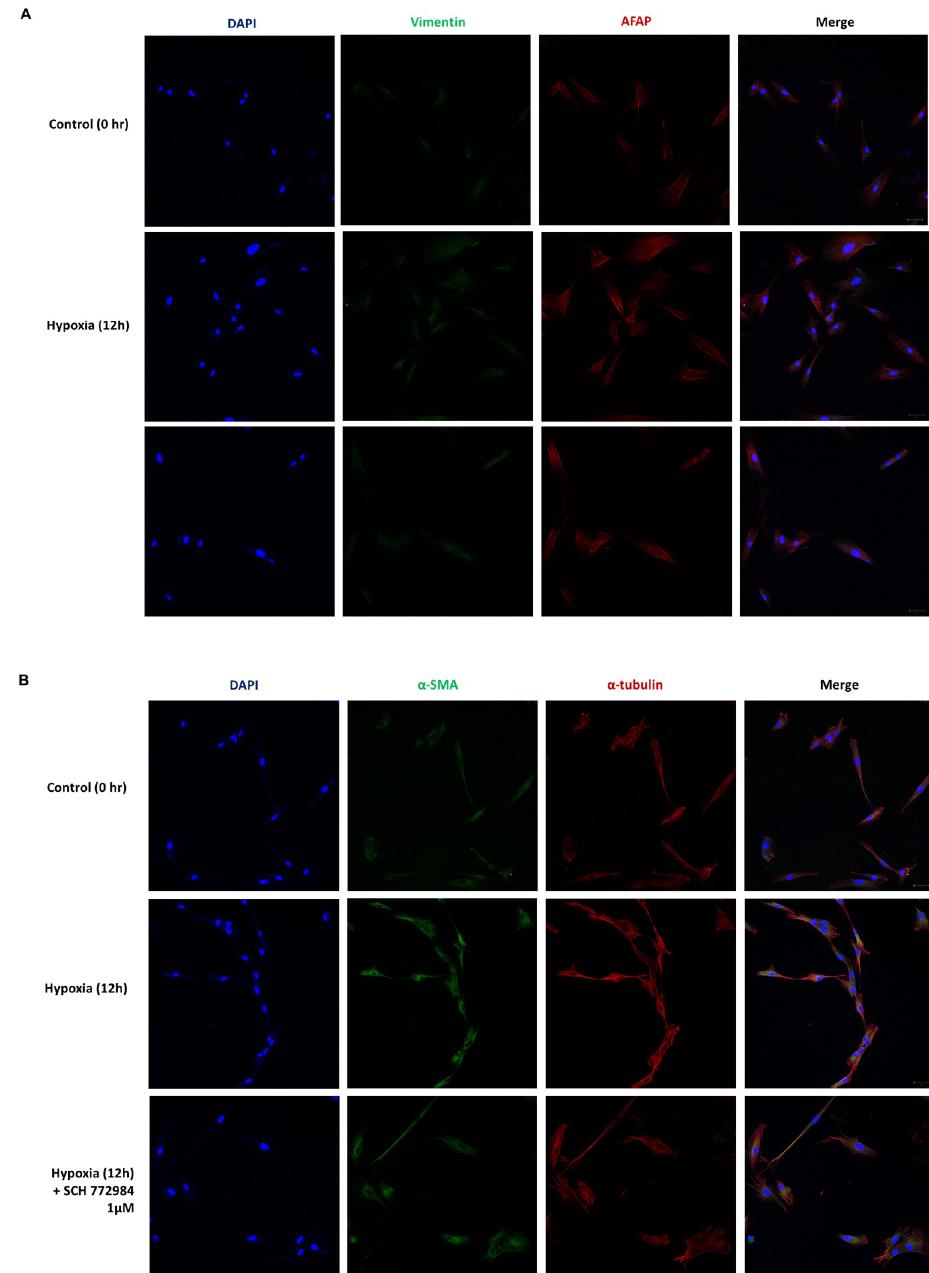
Figure 7. Effect of an ERK-specific inhibitor (SCH 772984) on phenotypic markers of EMT under hypoxia; DAPI (blue), vimentin (green, upper), α-SMA (green, lower), AFAP (red, upper), α-tubulin hypoxia; DAPI (blue), vimentin (green, upper), α -SMA (green, lower), AFAP (red, upper), α -tubulin (red, lower). (A) Increased expression of AFAP under hypoxia for 12 h were reduced after the (red, lower). ( A ) Increased expression of AFAP under hypoxia for 12 h were reduced after the treatment treatment of ERK inhibitors. (B) Increased expression of α-tubulin under hypoxia for 12 h were of ERK inhibitors. ( B ) Increased expression of α -tubulin under hypoxia for 12 h were reduced after the reduced after the treatment of ERK inhibitors. Results are representative of three independent treatment of ERK inhibitors. Results are representative of three independent experiments, scale bar = experiments, scale bar = 50 μM. 50 µ